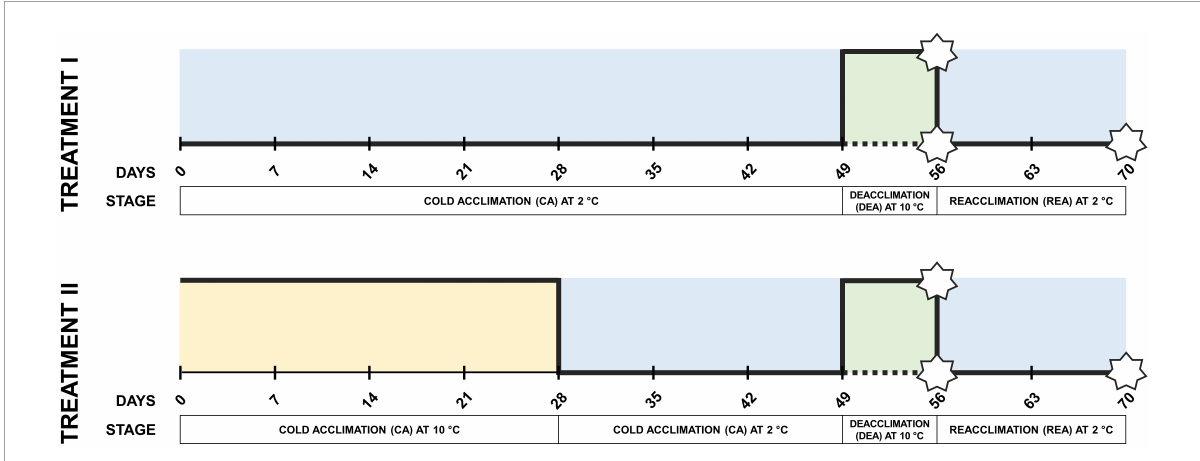
FIGURE1 Experimental design of two different low-temperature treatments during CA. Stars are used to indicate freezing tests of winter wheat performed after CA, DEA, and REA. Dotted lines indicate the subgroups which have not gone through 7 days of DEA, and thus, are fully acclimated at 56 days instead